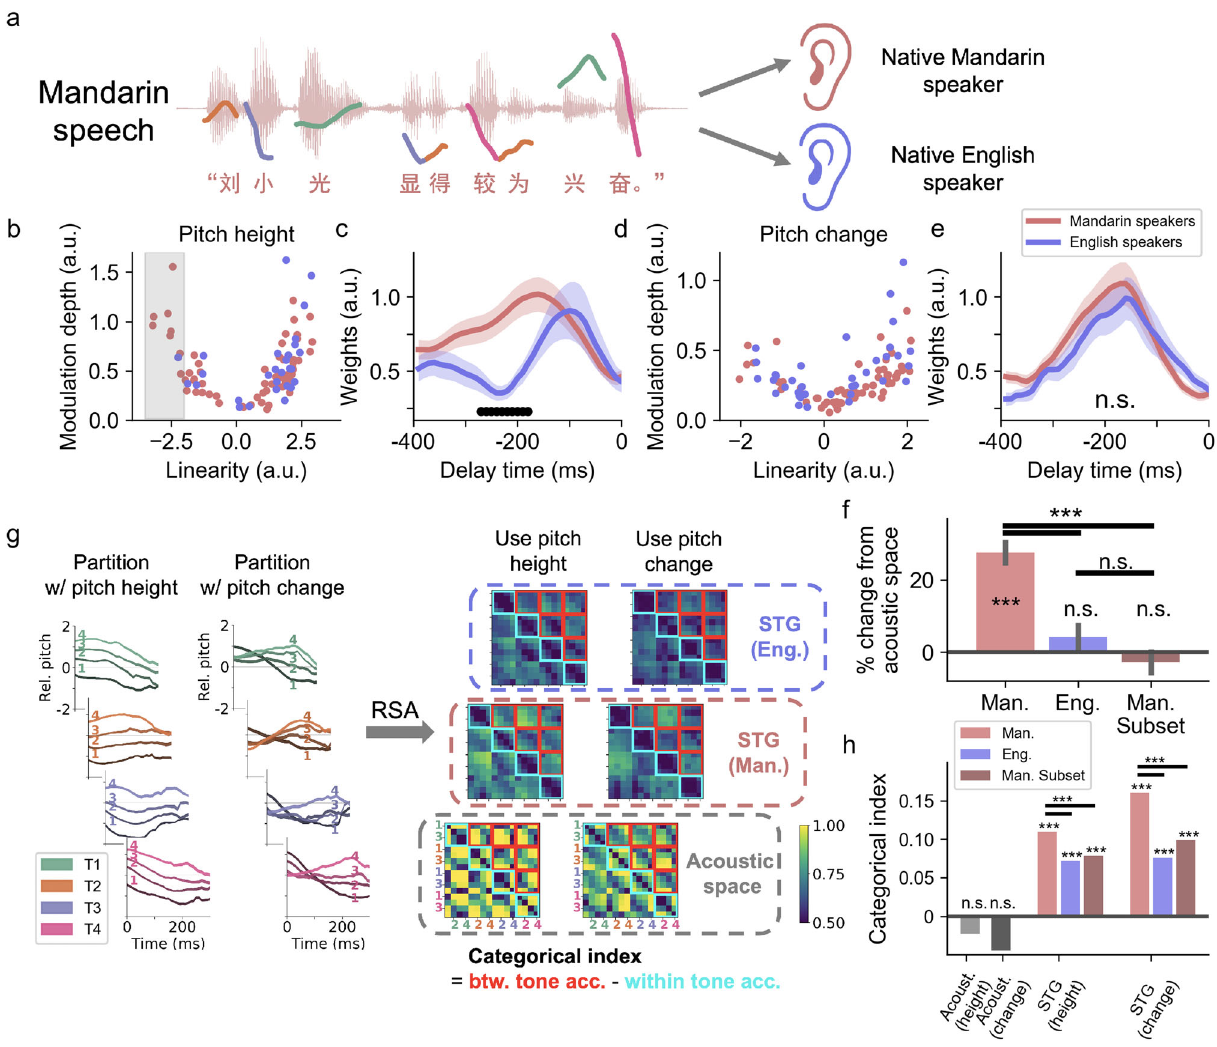
Fig. 5 Population neural activity in human STG supports categorical representation of lexical tones shaped by language experience. a Native Mandarin speakers and English speakers listen to the same Mandarin speech stimuli. b The scatterplot of the linearity versus the modulation depth for the tuning curves of relative pitch height in STG electrodes from native Mandarin speakers (red) versus native English speakers (blue). More negatively tuned electrodes are found in native Mandarin speakers (shaded gray area). c The averaged temporal receptive fi eld (absolute beta weights of the encoding regression model) for relative pitch height encoding electrodes in Mandarin (red) and English speakers (blue). (mean ± s.e.m., black markers indicate time points with signi fi cant difference between the two groups, FDR corrected α <0.05, two-sample two-sided t test). d Same as b , but for pitch change. e Same as c , but for pitch change. f The pair-wise tone classi fi cation accuracy relative to the accuracy in the acoustic space, using speech-sensitive electrodes (red: native Mandarin speakers; blue: native English speakers; dark red: native Mandarin speakers excluding strong negative tuning electrodes shown in b ); error bars indicate standard error of the mean estimation from n = 200 times bootstrapping. g Using partitions based on averaged relative pitch height and averaged pitch change respectively, representational similarity analysis (RSA) is performed on acoustic space and the population STG activity in native Mandarin speakers and native English speakers, respectively. Categorical index = mean between-tone classi fi cation accuracy (red blocks) – mean within-tone classi fi cation accuracy (cyan blocks). h The categorical index based on acoustic relative pitch contour, STG population space in native Mandarin speakers (red) and STG subset excluding negative tuning electrodes (dark red), as well as in native English speakers (blue) (*** p <0.005, n.s. p > 0.1, permutation